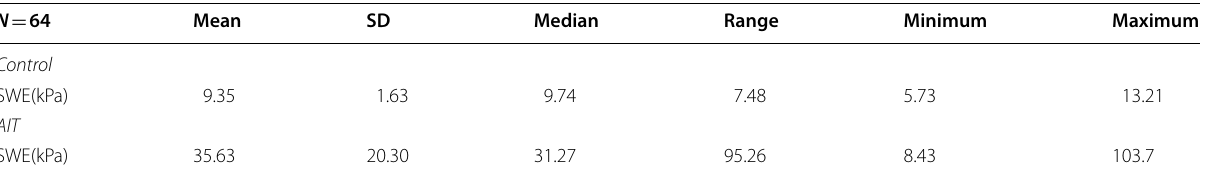
Table 5 Showing demographic data of SWE in healthy control and